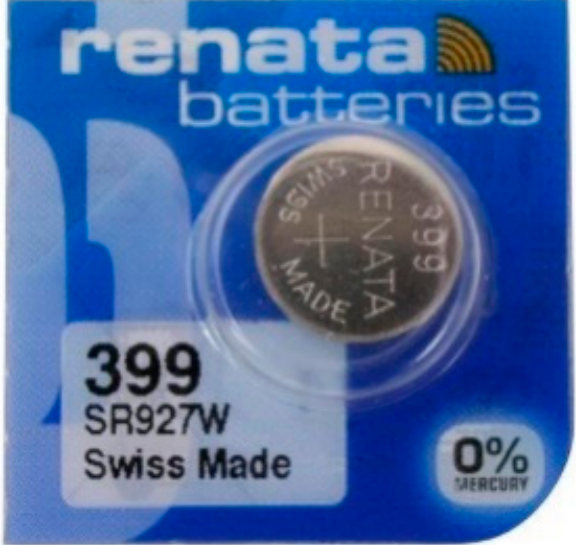
Figure 5. 399 Renata battery .